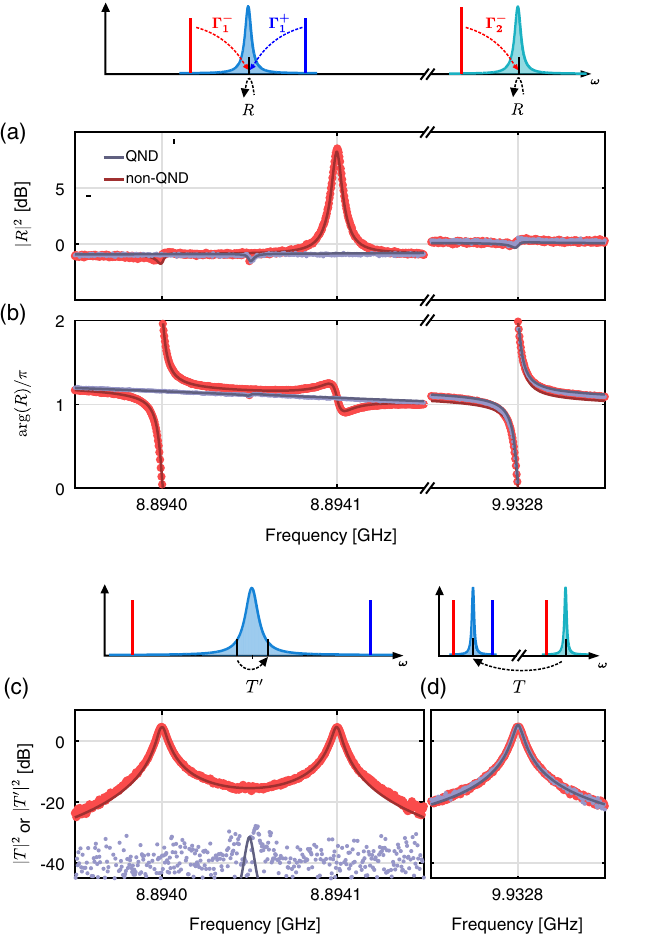
FIG. 7. Driven responses for the tomography of the mechanical squeezed state. Data corresponding to the measurement setup in FIG. 6. Driven responses for the QND and non-QND meas- Fig. 3: the pump scattering rates are Γ − 2 ¼ 2 π × 15 . 11 kHz ¼ urement. Data corresponding to the measurement setup in Fig. 2: 1643 Γ the pump scattering rates are Γ − 2 ¼ 2 π × 4 . 87 kHz ¼ 529 Γ and , Γ − 1 = Γ − 2 ¼ 0 . 48 , and Γ þ 2 = Γ − 2 ¼ 0 . 07 . (a), (b) Reflection m m Γ − ¼ Γ þ ¼ 0 . 9 Γ − coefficient R around each cavity resonance. (c) Transmission T 0 1 2 . (a), (b) Reflection coefficient R around each 1 cavity resonance. (c) Transmission T 0 from the upper mechanical from the upper mechanical sideband of the red measurement sideband of the red measurement drive to the lower mechanical drive to the lower mechanical sideband of the blue measurement sideband of the blue measurement drive, as a function of the input drive, as a function of the input frequency. A signal sent at ω is frequency. A signal sent at ω is received at ω − ω − 1 þ ω þ 1 . received at ω − ω − 1 þ ω þ 1 . (d) Transmission T from the upper (d) Transmission T from the upper mechanical sideband of the mechanical sideband of the red cooling drive to the upper red cooling drive to the upper mechanical sideband of the red mechanical sideband of the red measurement drive, as a function measurement drive, as a function of the input frequency. A signal of the input frequency. A signal sent at ω is received at ω − ω − þ ω − sent at ω is received at ω − ω − 2 þ ω − 1 . All the solid lines are from 2 1 . All the solid lines are from the same numerical the same numerical simulation.